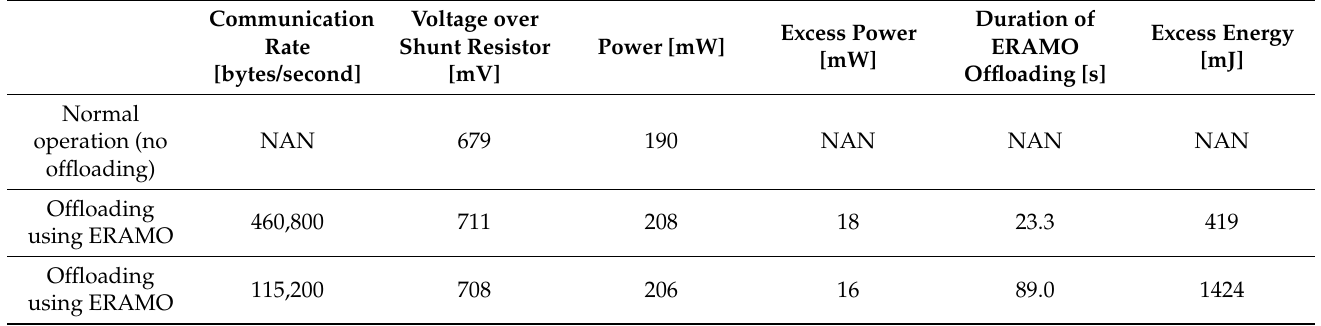
Table 2. Energy usage in ERAMO for different communication